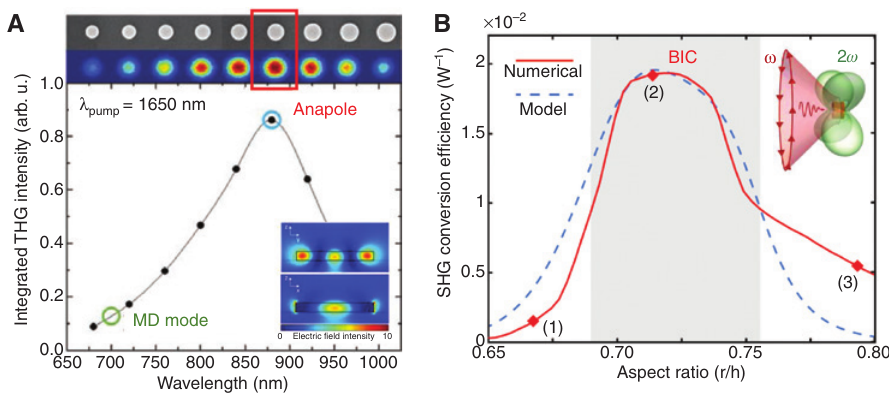
Figure 4: Enhanced harmonic generation. (A) Observation of the enhanced nonlinear THG in Ge nanodisks near the anapole conditions. Insert shows the numerically simulated field structure of the anapole. Adapted with permission from [116]. (B) Predicted giant SHG near the BIC conditions in AlGaAs nanorod. Insert shows the multipolar field structure. Adapted with permission from